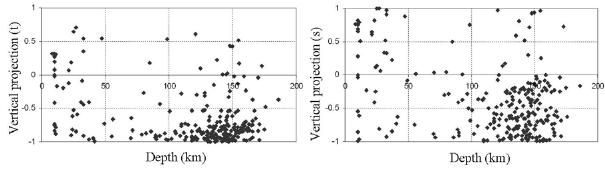
Results and Discussion